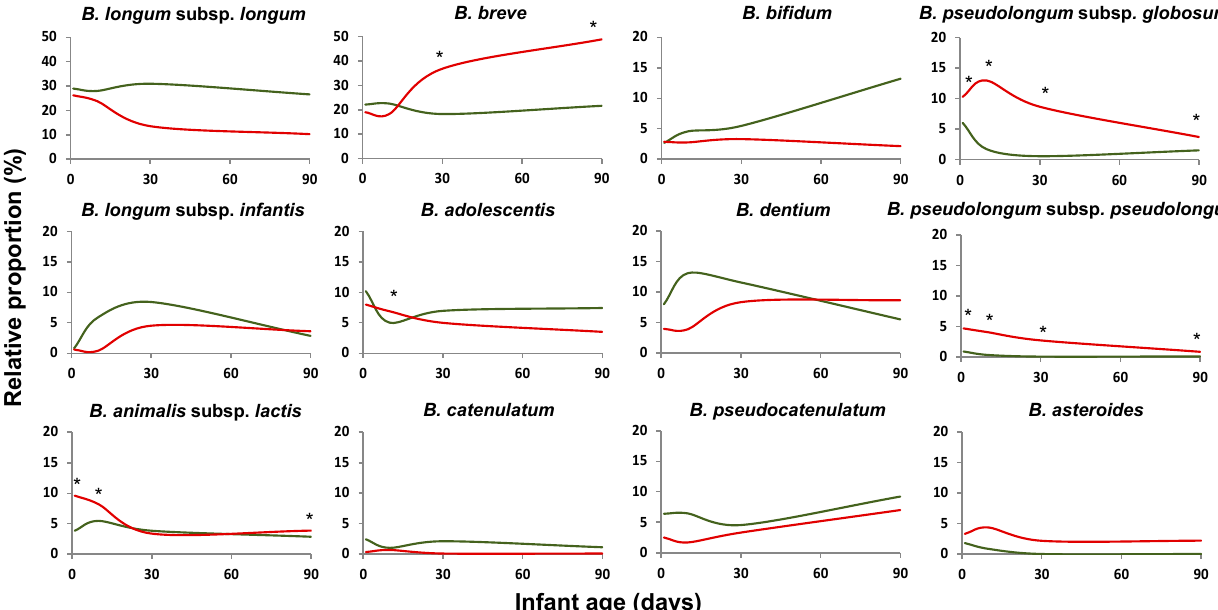
Figure 1. Impact of prematurity. Average relative proportions, with regard to total bifidobacteria (100%), of the dominant Bifidobacterium species/subspecies (based on the sequencing of the internal intranscribed spacer (ITS)-region between the 16S and 23S rRNA genes) during the first three months of life in full-term (green line) and preterm (red line) newborns. * Indicates statistically significant differences ( p < 0.05) at the corresponding sampling times (two, 10, 30, or 90 days of age).